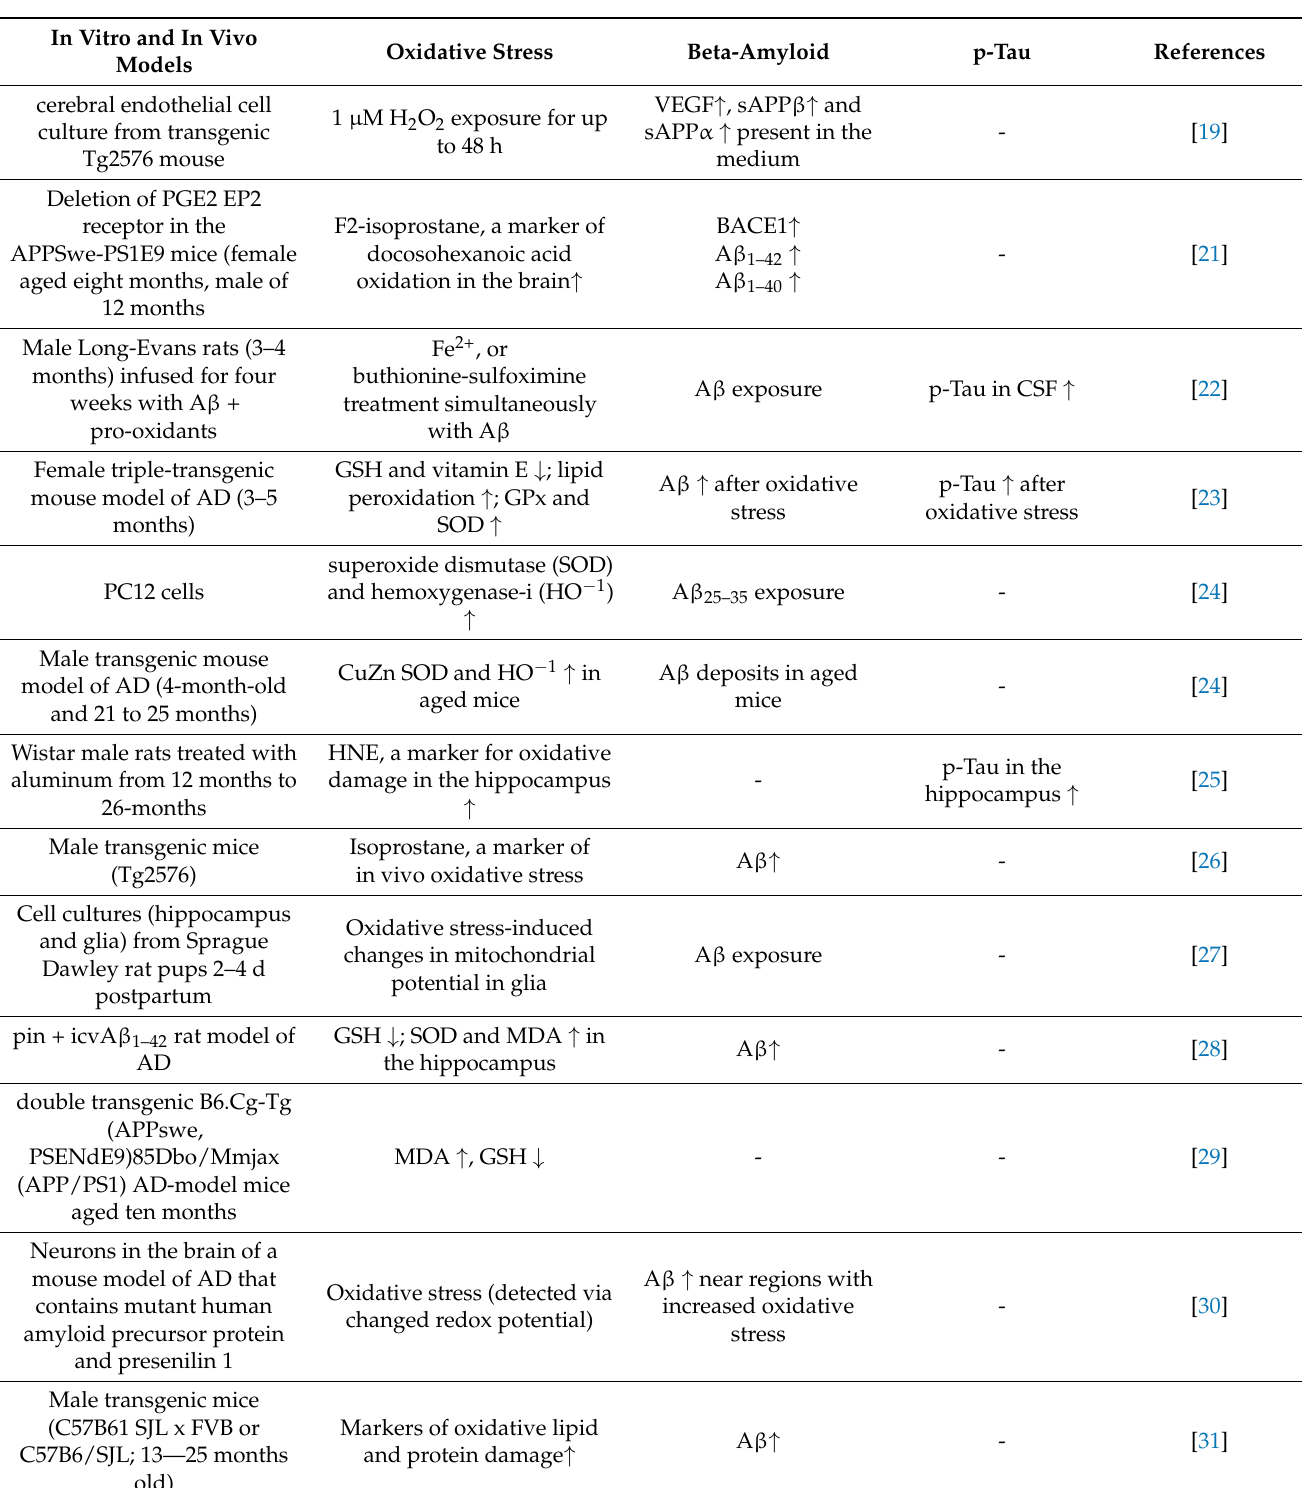
Table 1. In vitro and in vivo models considering the link between oxidative stress, beta-amyloid (A β ) peptide, and hyperphosphorylation of tau protein